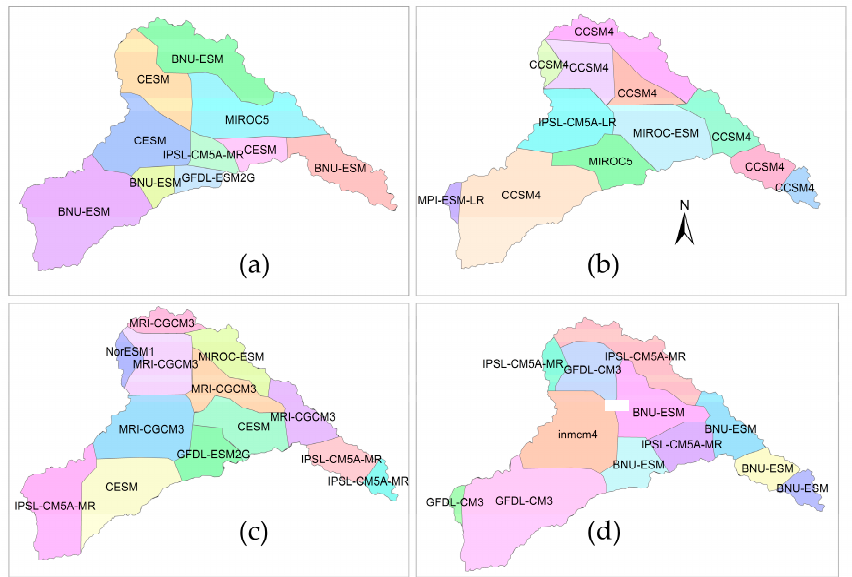
Figure 9. The spatial distribution of the highly correlated general circulation models (GCMs) with the observed data in each respective climate zone for the ( a ) warm-wet, ( b ) cold-dry, ( c ) cold-wet and ( d ) warm-dry seasons.